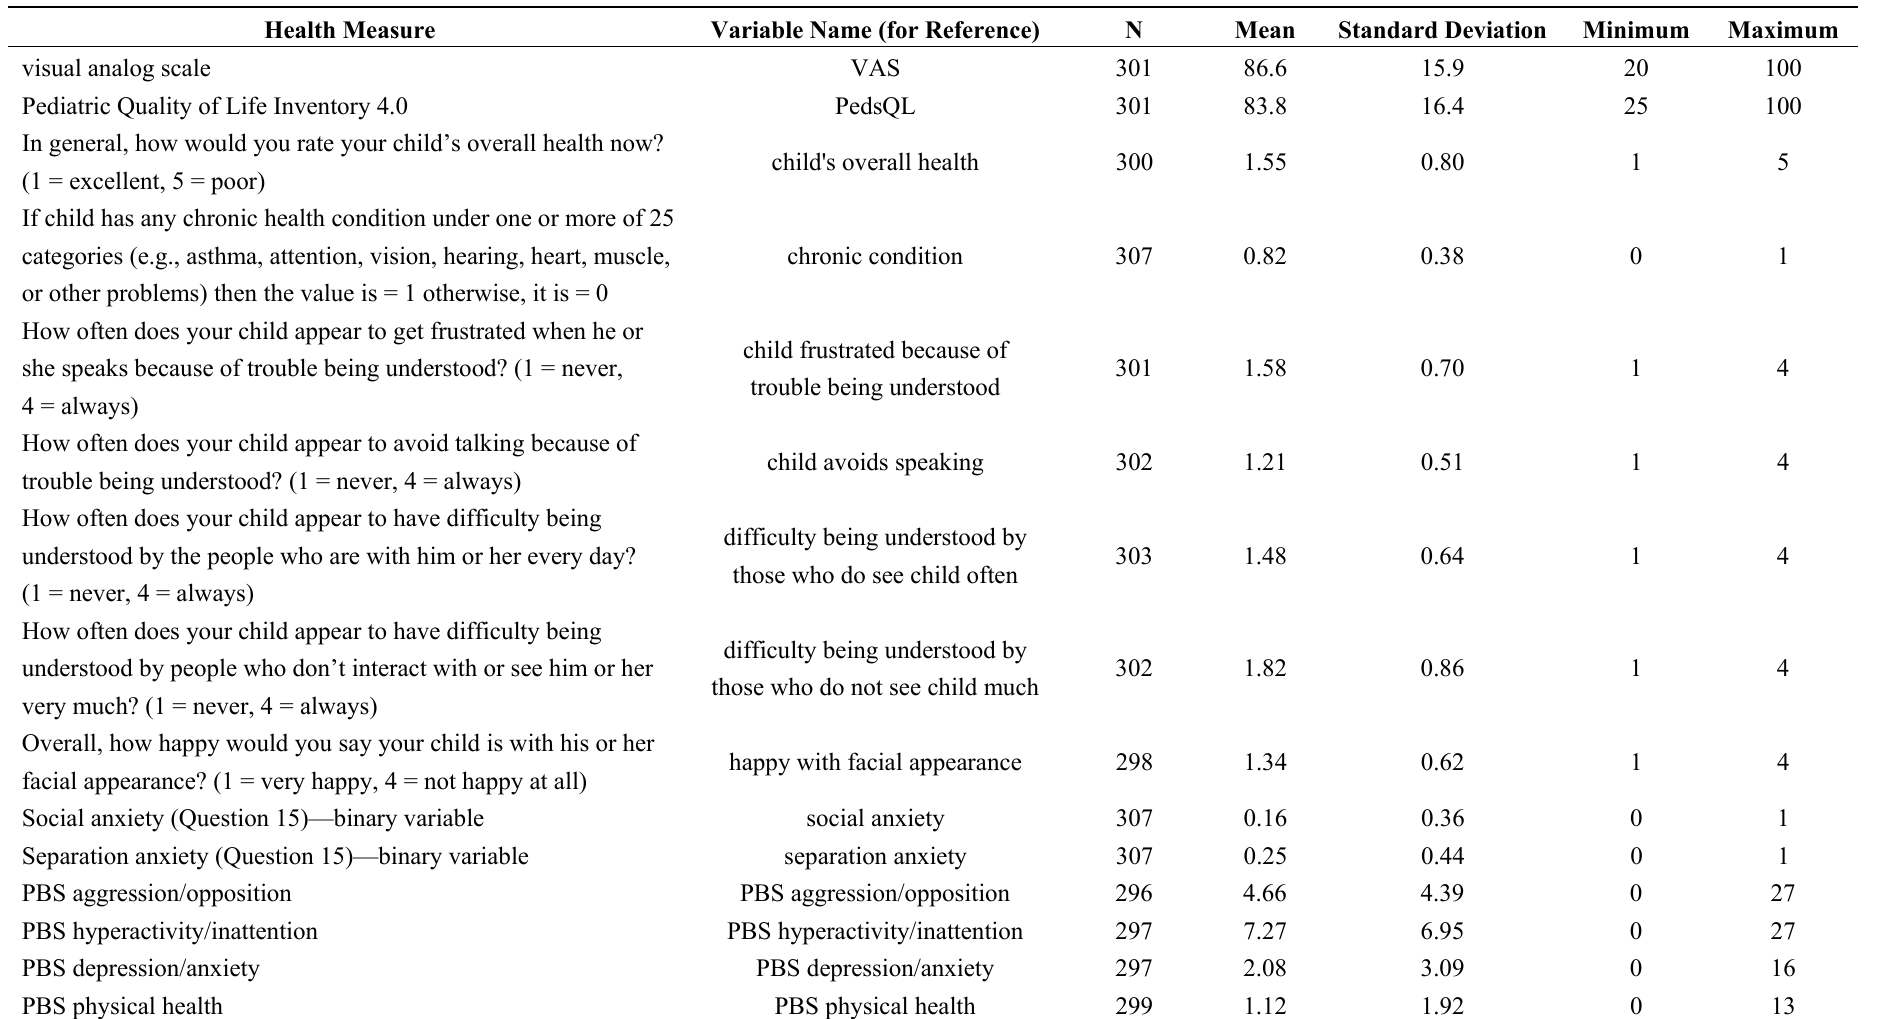
Table 1. Variable Description and Descriptive